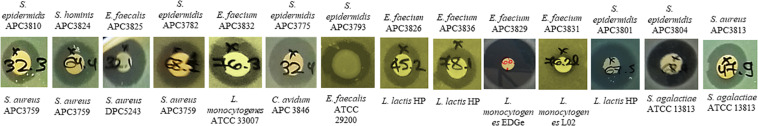
Representative zones of inhibition from a selection of the 29 antimicrobial producers that demonstrated the strongest inhibition against S. aureus APC 3759 and M. luteus DSM 1790 against a selection of the 29 indicator strains.